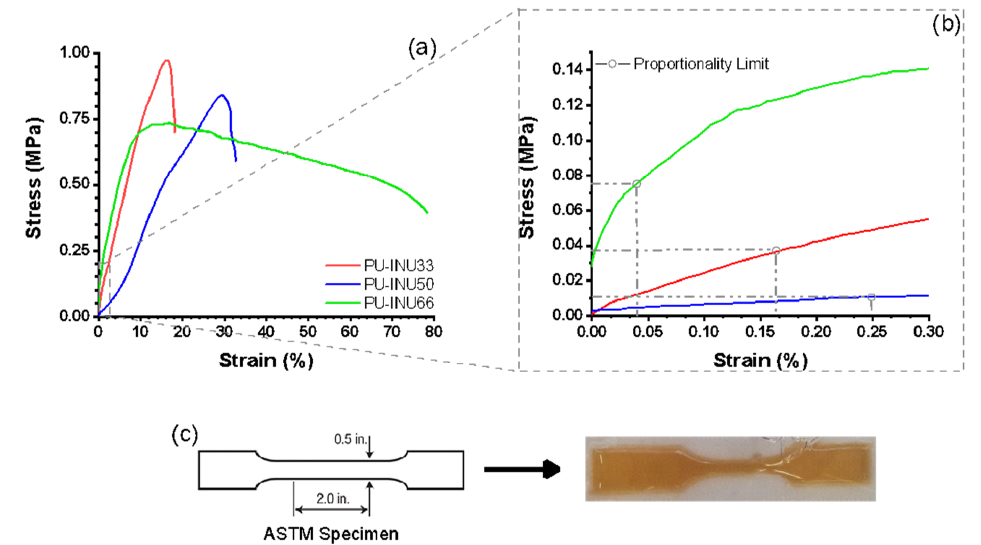
Figure 5. Mechanical behavior of the synthesized PU–INU. ( a ) Mechanical properties until maximum tensile strength was reached, ( b ) mechanical properties in the elastic region, and ( c ) example of the required specimen according to ASTM-D638-03 standard and the actual film.